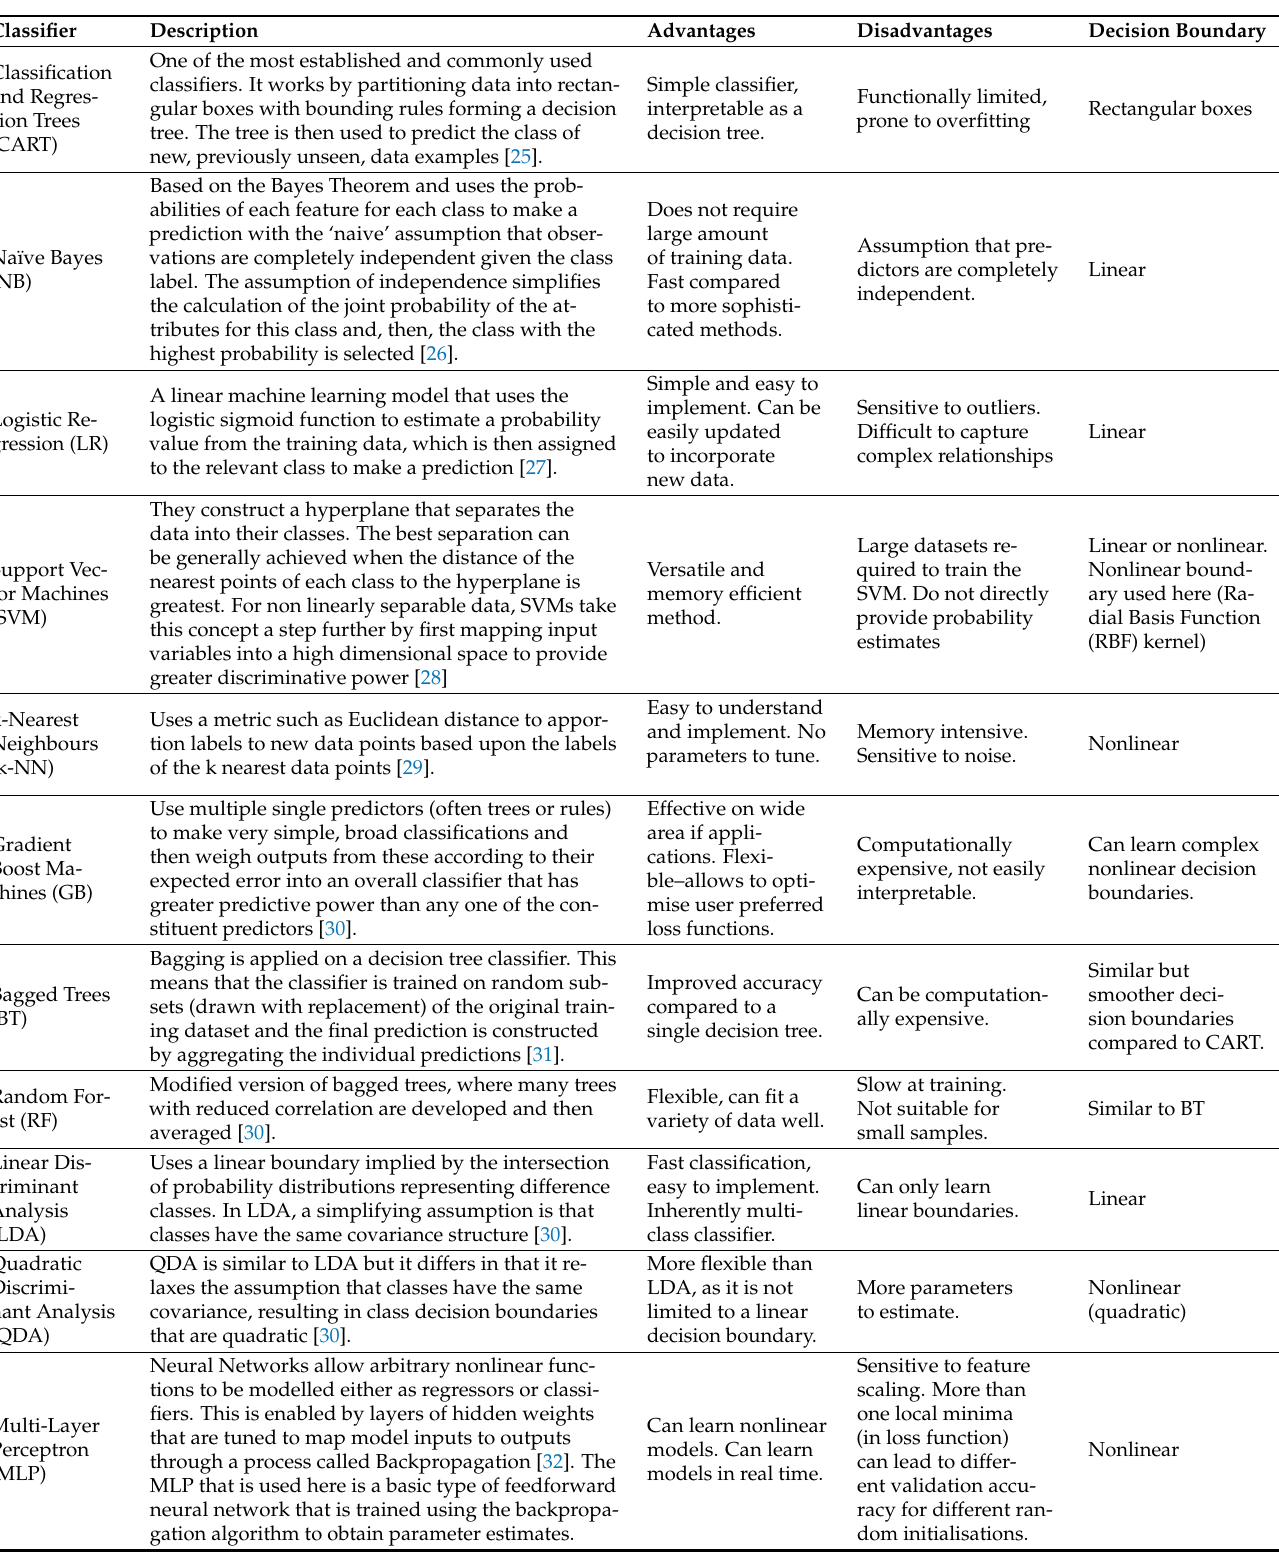
Table 4. Characteristics of classification